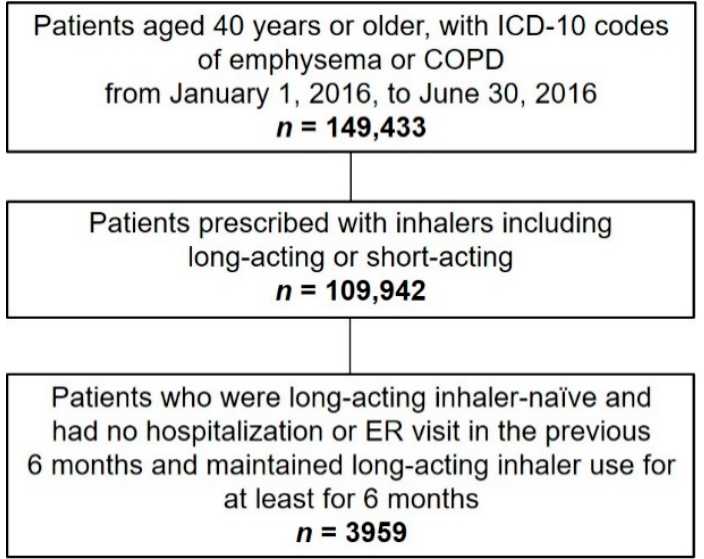
Figure 1. Flow chart describing the details for the number of patients in this study. ICD-10, Interna- tional Classification of Diseases-10th Revision; COPD, chronic obstructive pulmonary disease; ER, emergency room.